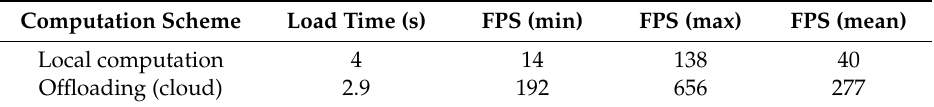
Table 1. Summarized results of local computation vs. offloading to